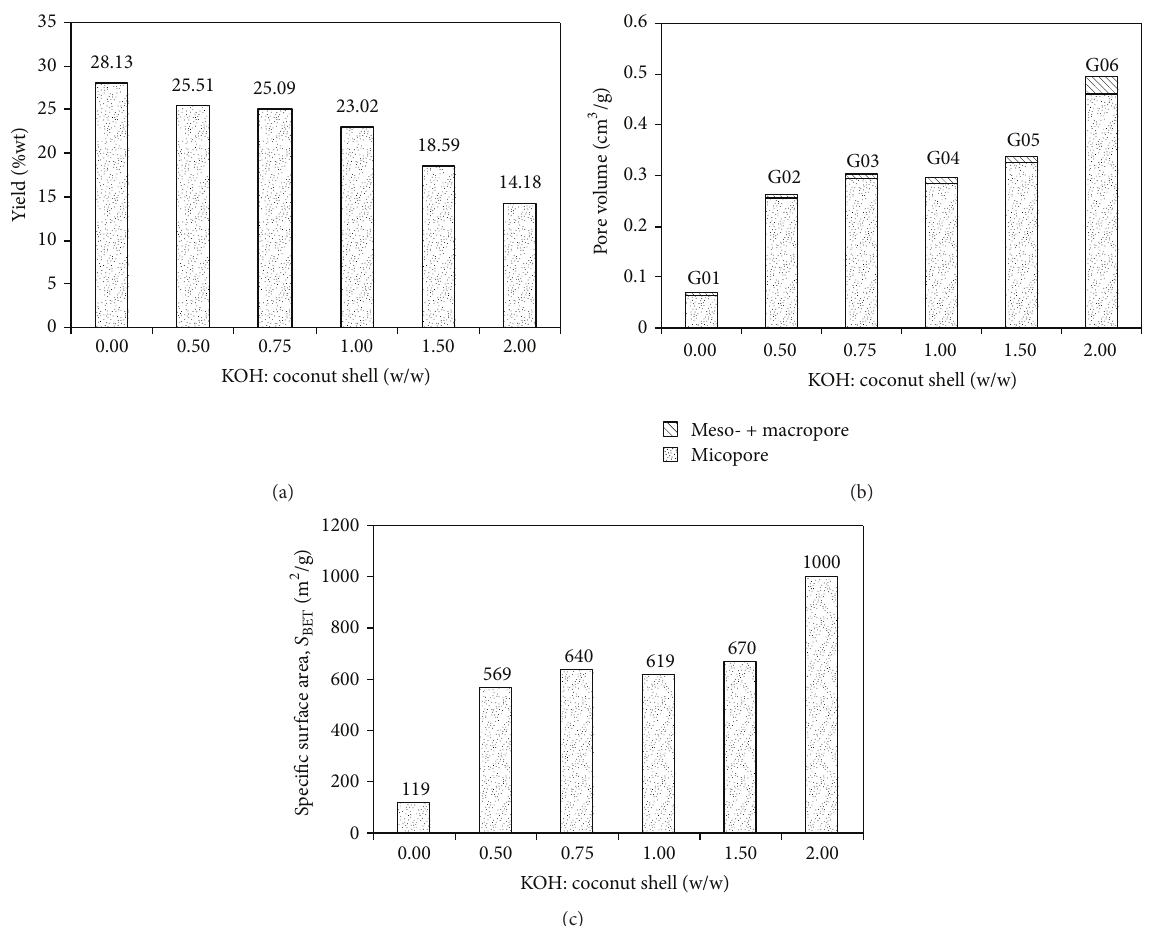
Figure 8: Effect of chemical ratio on (a) yield, (b) the pore volume, and (c) specific surface area ( 𝑆 BET ) of activated carbon from coconut shell gasification with potassium hydroxide and carbon dioxide at gasification temperature of 600 ∘ C for 180 min and without carbonization step.